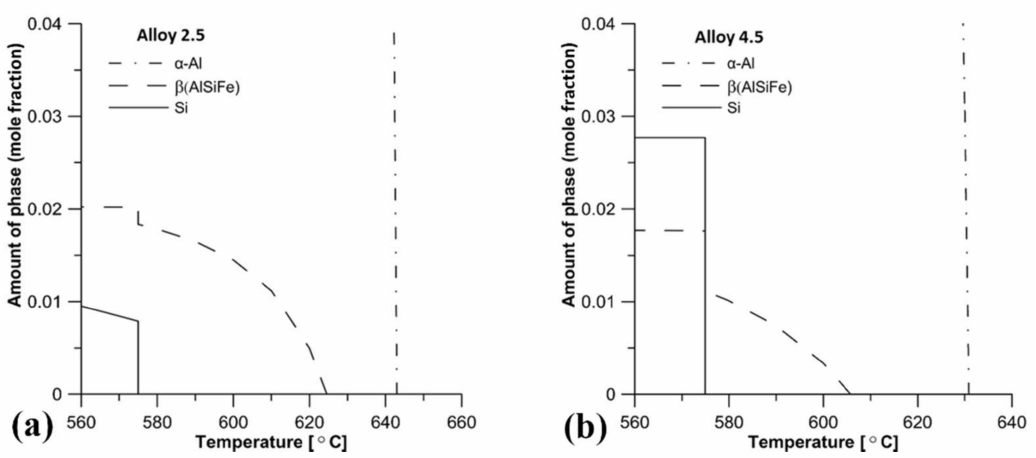
Figure 2. Sequence of formation of different phases in the ( a ) Alloy 2.5 and ( b ) Alloy